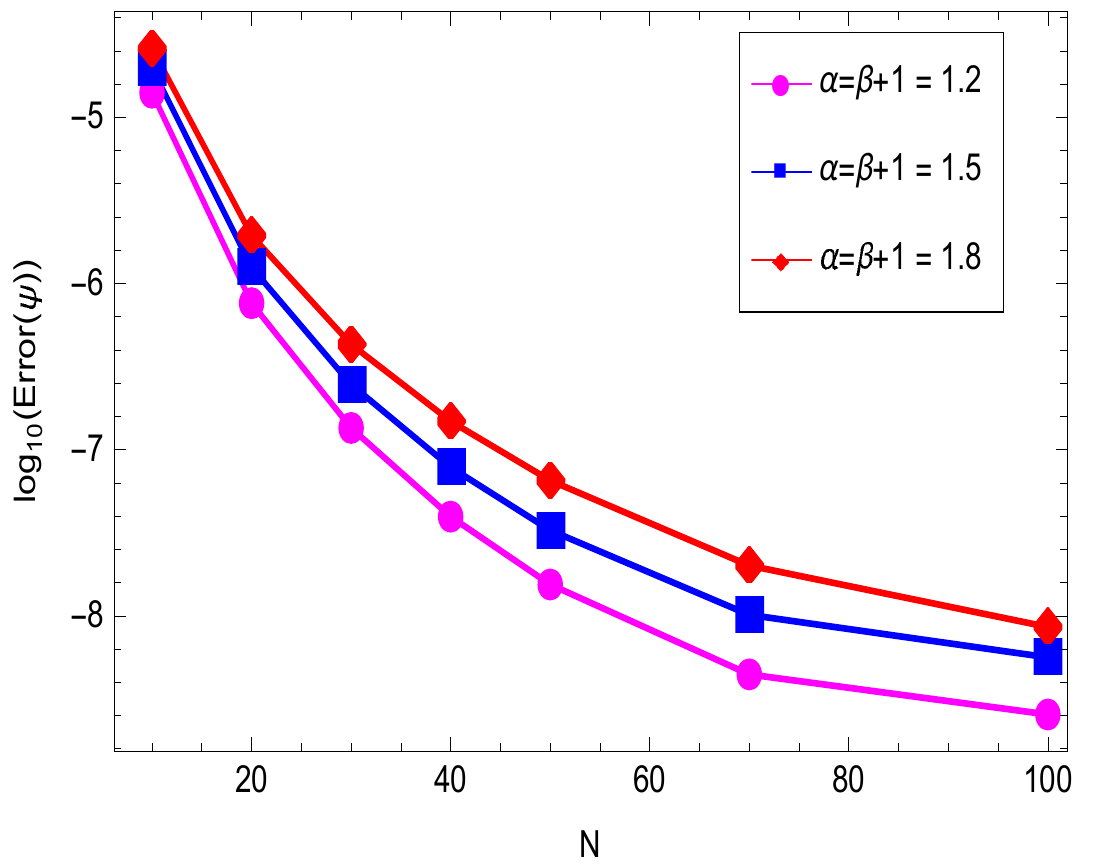
Figure 2. Convergence order of ψ in space for different values of α and β at M =